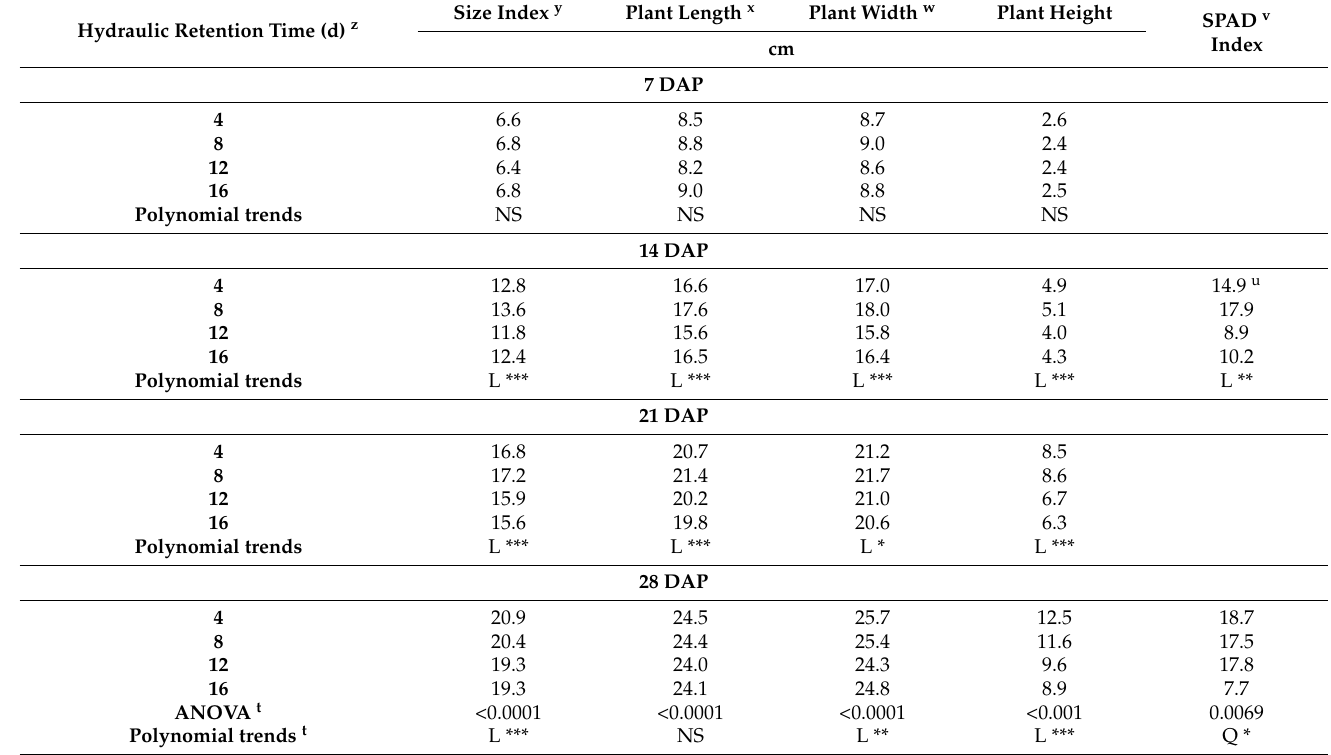
Table 1. Size index and SPAD of ‘Rex’ butterhead lettuce ( Lactuca sativa ) HRT without iron supple- mentation, simple effects of HRT at measurement week.